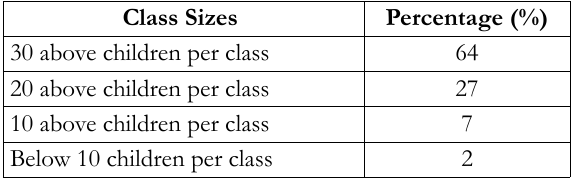
Table 6. Percentage of teacher responses for class sizes. (Questionnaire)